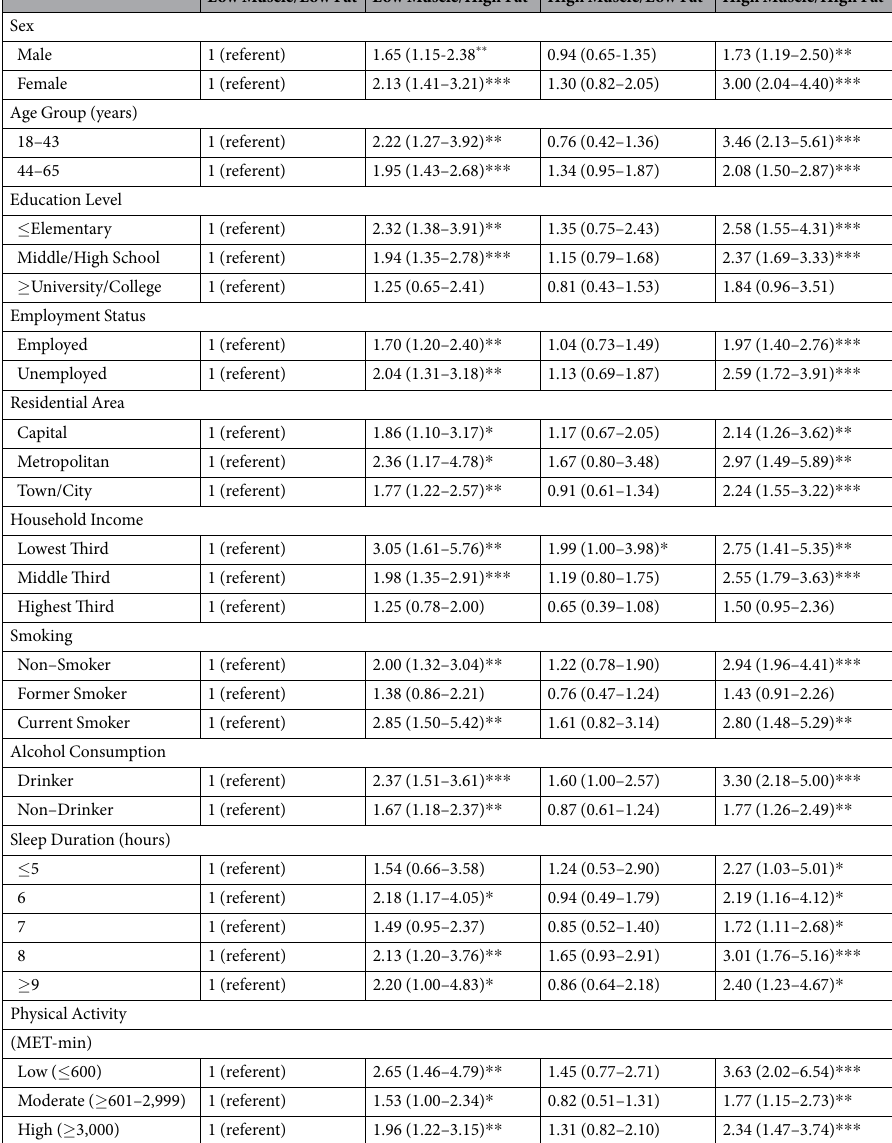
Table 4. Subgroup Analysis for the prevalence of metabolic syndrome based on ATP III criteria by muscle mass and fat mass. Data presented are IRR (95% CI). All IRR (95% CI) presented above are from multivariable model 3 (adjusted for for age, sex, education, employment status, area of residence, household income, smoking, alcohol consumption, sleep duration, physical activity, BMI, and presence of comorbidity, total energy intake, vitamin C, niacin, sodium, calcium, and fiber). Criteria for metabolic syndrome was defined as meeting three or more of the following conditions as suggested by the NCEP ATP III: (1) Impaired Fasting Glucose ( ≥ 100 mg/ dL), (2) Elevated WC ( > 90 cm for men and > 85 cm for women), (3) High Blood Pressure (SBP: ≥ 130 mmHg and DBP: ≥ 85 mmHg), (4) High Triglyceride ( ≥ 150 mg/dL), (5) Reduced HDL-cholesterol ( < 50 mg/dL for men and < 40 mg/dL for women). * Categorized as normal ( < 22.9 kg/m 2 ), overweight (23–24.9 kg/m 2 ), obese (25–29.9 kg/m 2 ), severely obese ( ≥ 30 kg/m 2 ) based on WHO criteria for Asian population. Abbreviations: BMI, Body Mass Index; WHO, World Health Organization; IRR, Incidence Rate Ratio; CI, Confidence Interval; WC, Waist Circumference; SBP, Systolic Blood Pressure; DBP, Diastolic Blood Pressure; HDL, High Density Lipoproteins; NCEP ATP III, National Cholesterol Education Program-Adult Treatment Panel III; Note: Each category of muscle mass and fat mass is compared to low muscle/low fat group (reference). * p < 0.05, ** p < 0.01, *** p < 0.001 (reference group is low muscle/low